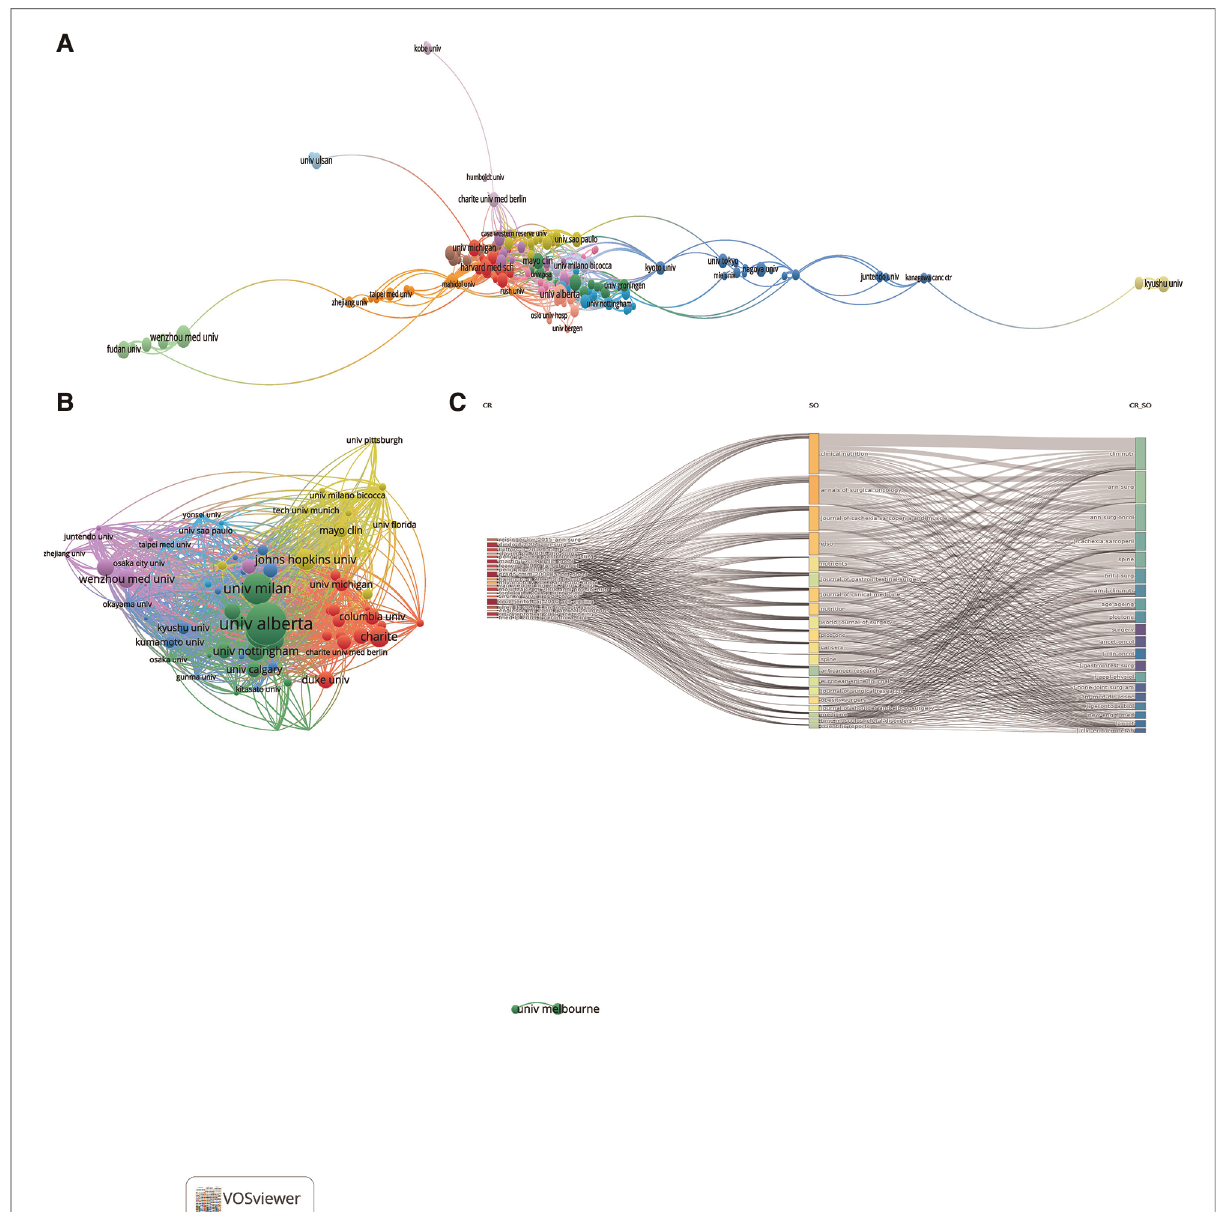
FIGURE 2 Analysis of relationships between institutions and the cited relationship between journals. ( A ) Map of collaborative relationships between institutions: different nodes present different institutions. The size of nodes is proportional to the number of publications in each institution, and the color of the lines between two nodes presents the collaborative relationship between institutions; ( B ) Map of citation relationships between institutions: the size of nodes represents the number of citations and the line means their citation relationship; ( C ) Map of cited relationships between journals: the left column means the publications with the most co-cited times, the middle column means the journals with the most co-cited times, and the right column means the journals with the most